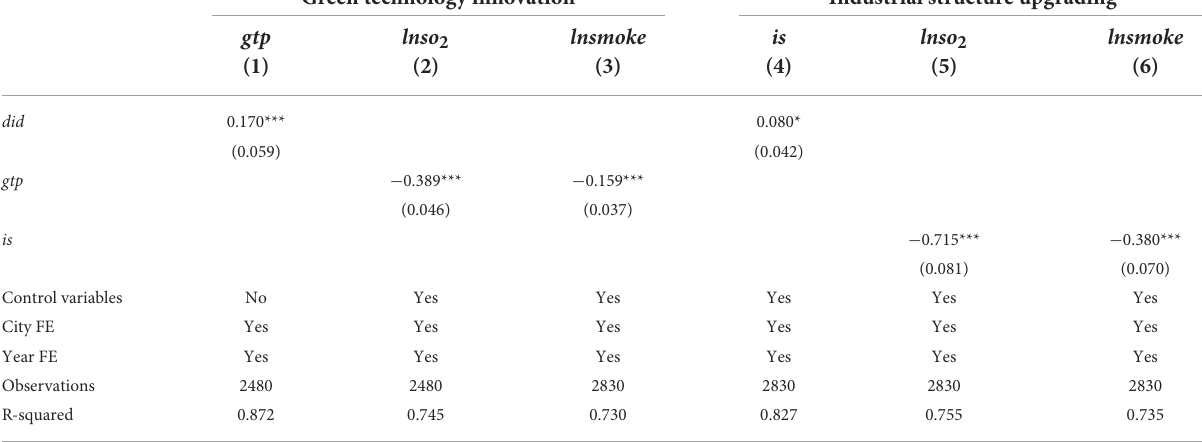
TABLE 5 Analysis results of influence mechanism.